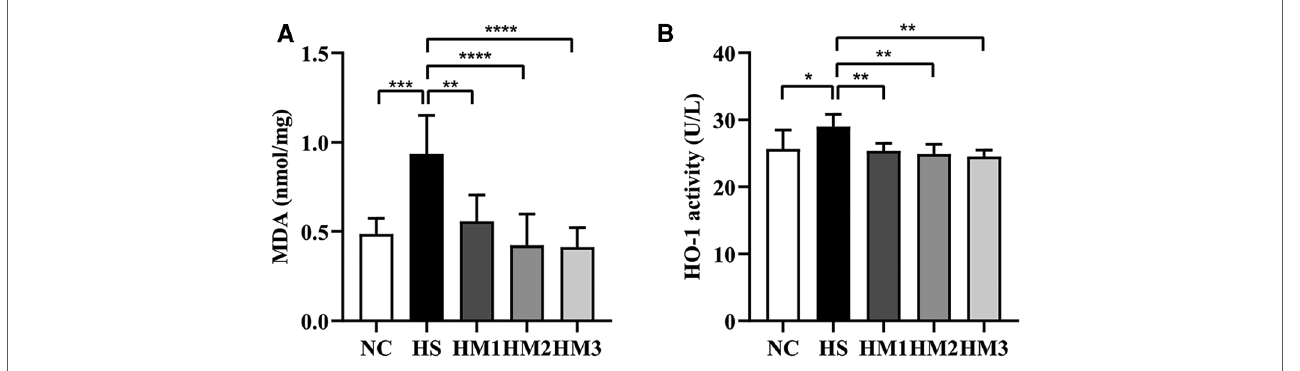
FIGURE 6 Human umbilical cord-derived mesenchymal stem cells (hUC-MSCs) reduces the level of MDA concentration ( A ) and HO-1 activity ( B ). The rat pups reared in the HS group showed signi fi cantly higher level of MDA concentration and HO-1 activity than did those reared in the NC group. hUC-MSCs (1×10 6 cells, 5× 10 6 cells, or 1×10 7 cells) diminished the hyperoxia-induced MDA level and HO-1 activity increases. * P <0.05, ** P <0.01, *** P <0.001, and **** P <0.0001. Data was presented as means±SEM, n =6-8 per